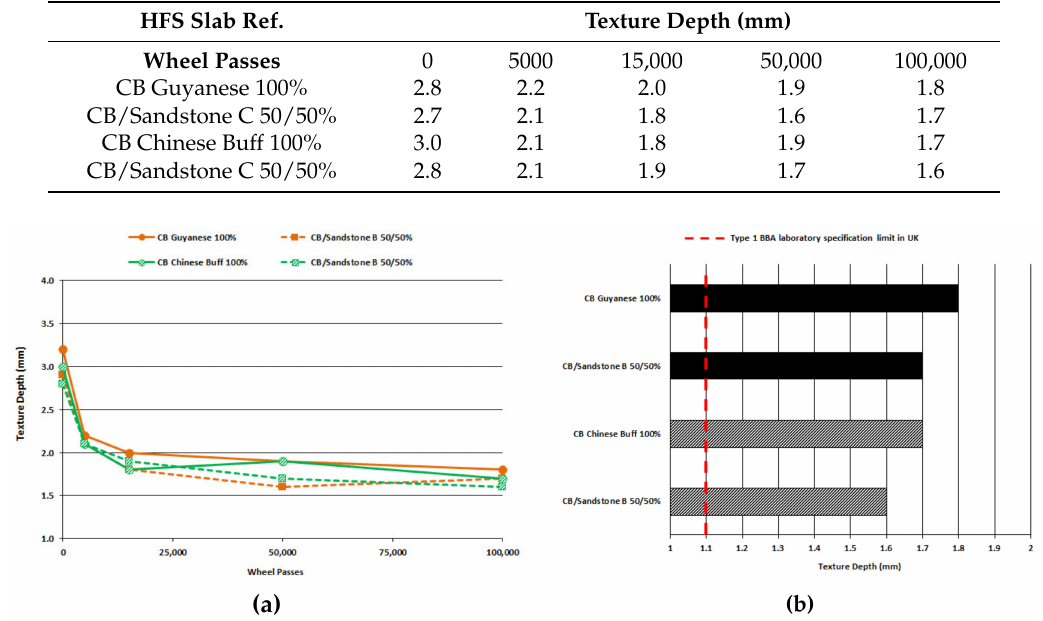
Table 7. Texture depth data (Ulster University data).